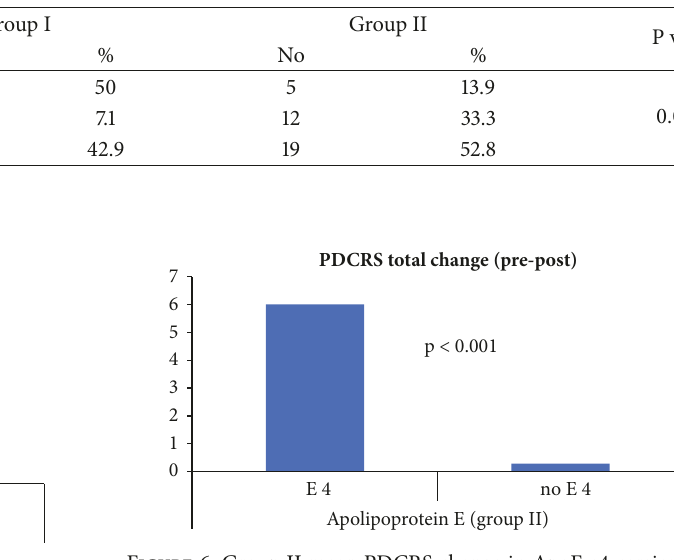
Table 3: Number and percentage of different MAPT haplotypes in Group I and Group II patients.